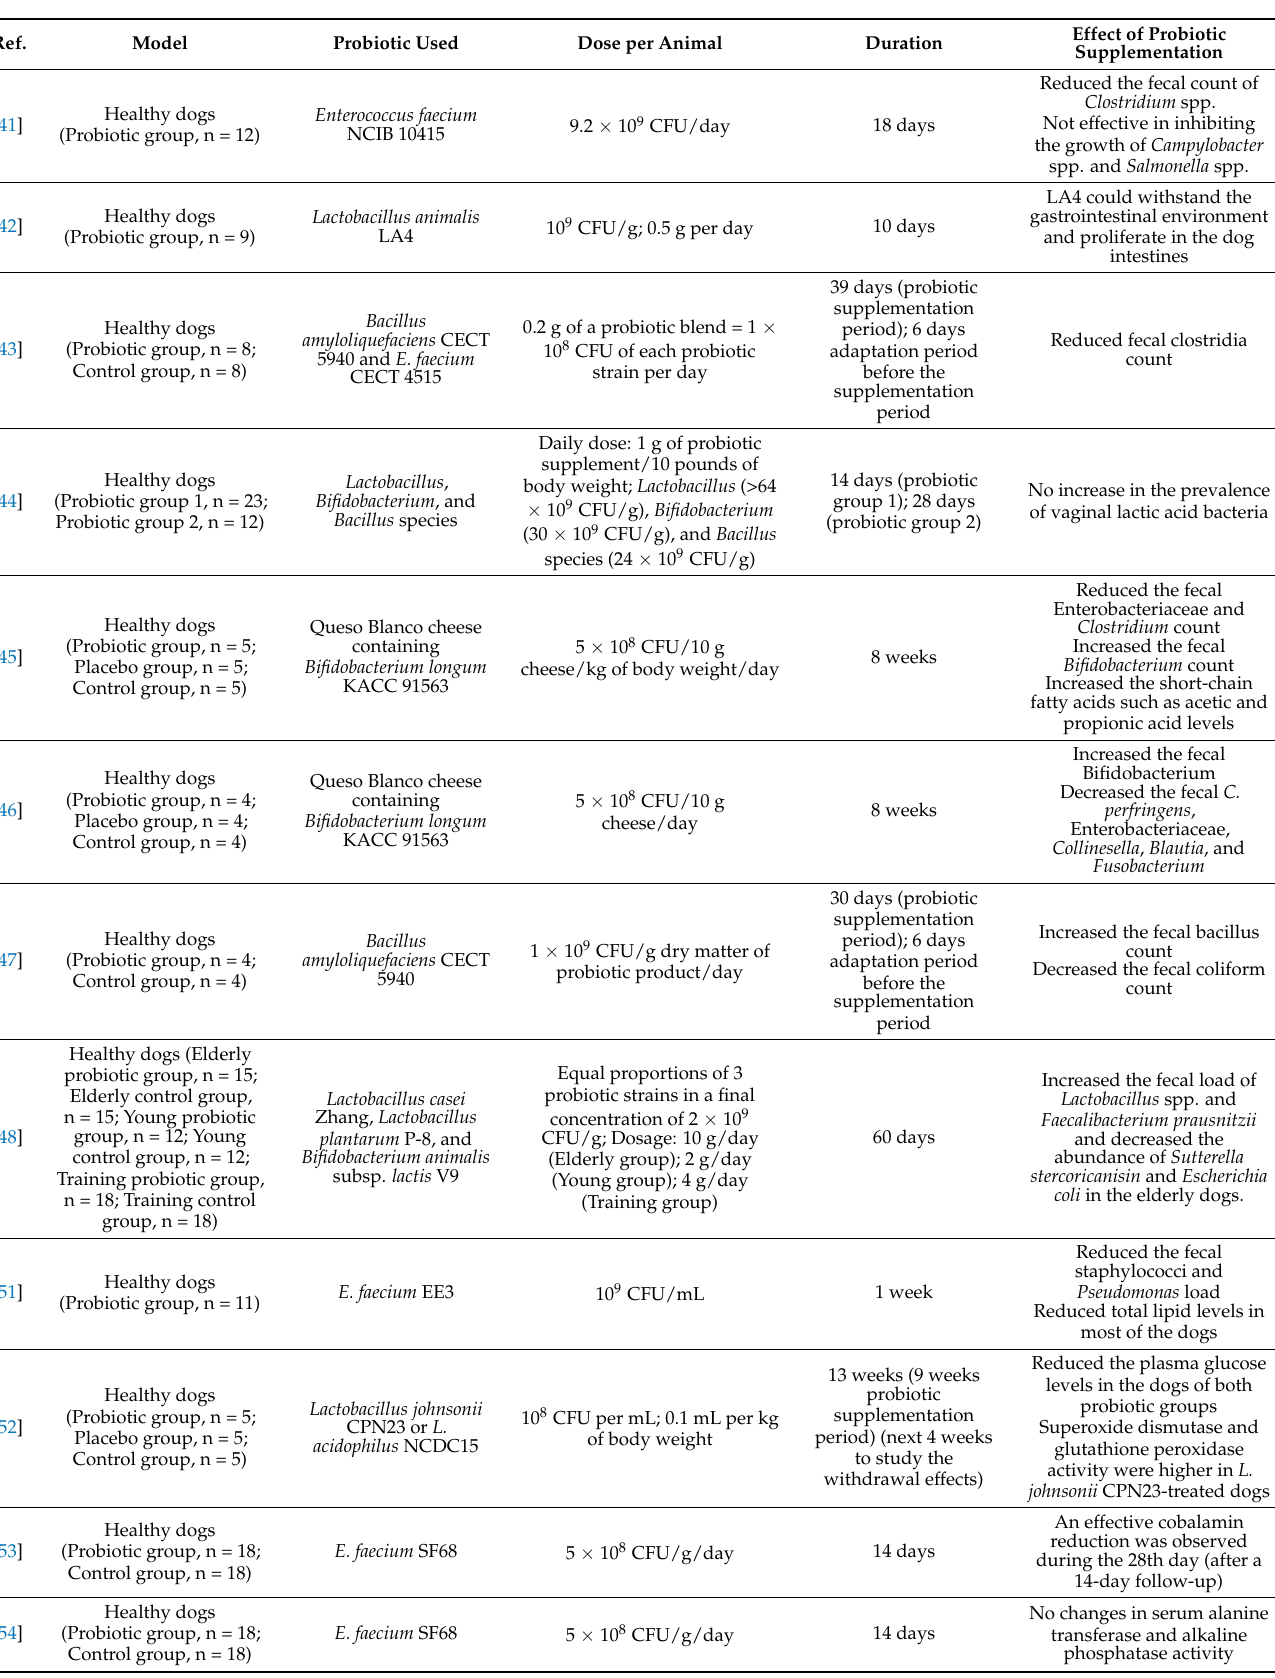
Table 1. The effects of probiotic supplementation on the health status of healthy